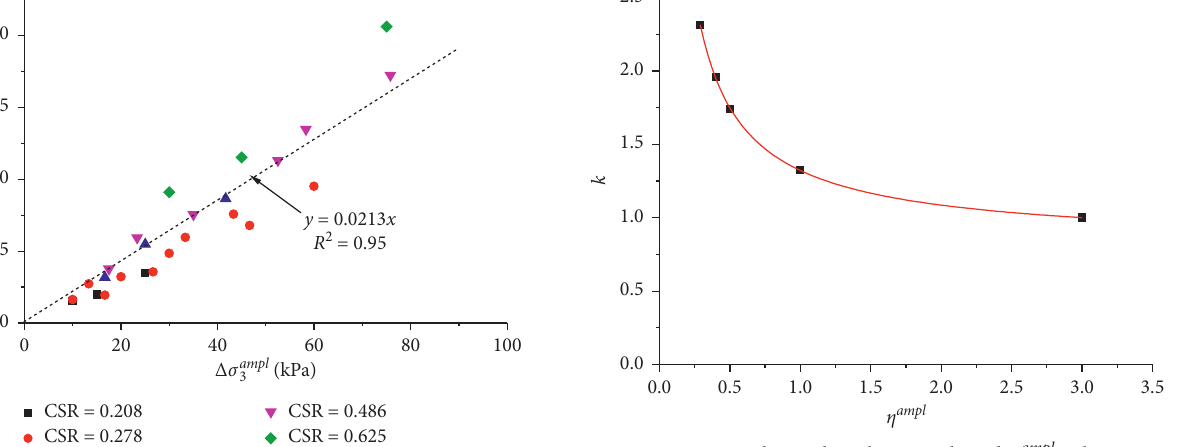
Figure 14: Relationships between k and η ampl values.